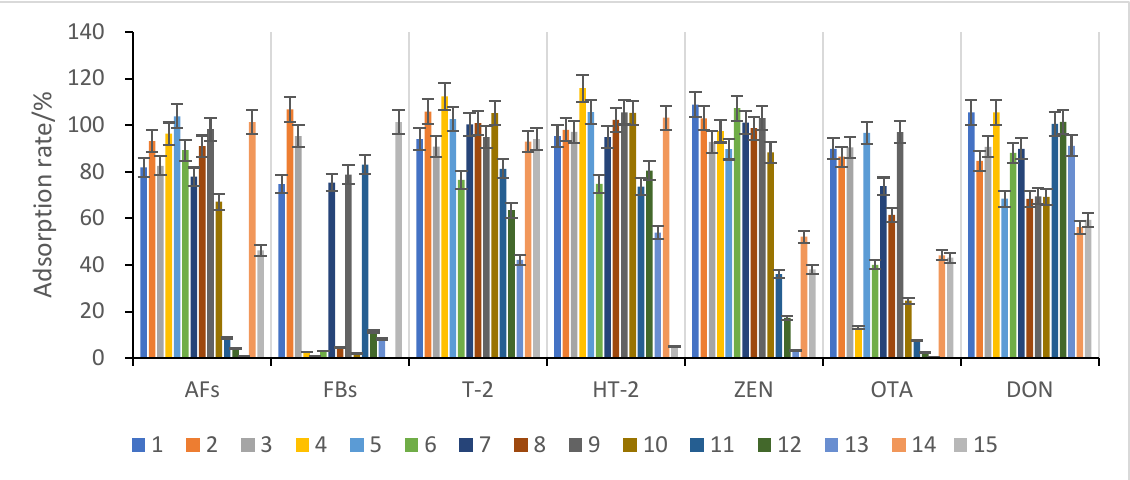
Figure 3. Comparison of the adsorption effect of different purification and adsorption materials on impurities in maize species. Error bars are the standard deviation of the results of 3 measures, like below.